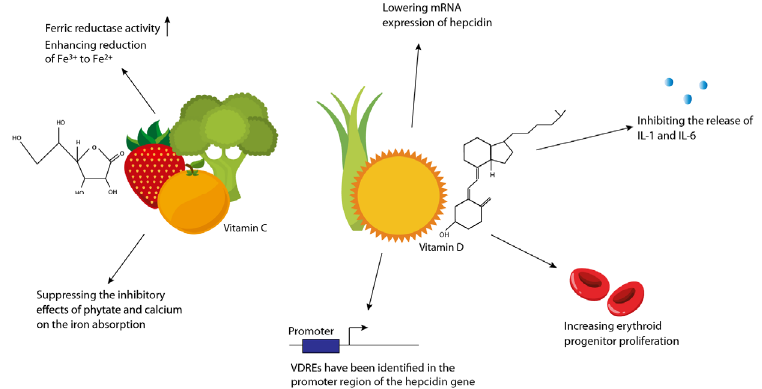
Figure 2. Importance of vitamins C and D in the treatment of iron ‐ deficiency anaemia.